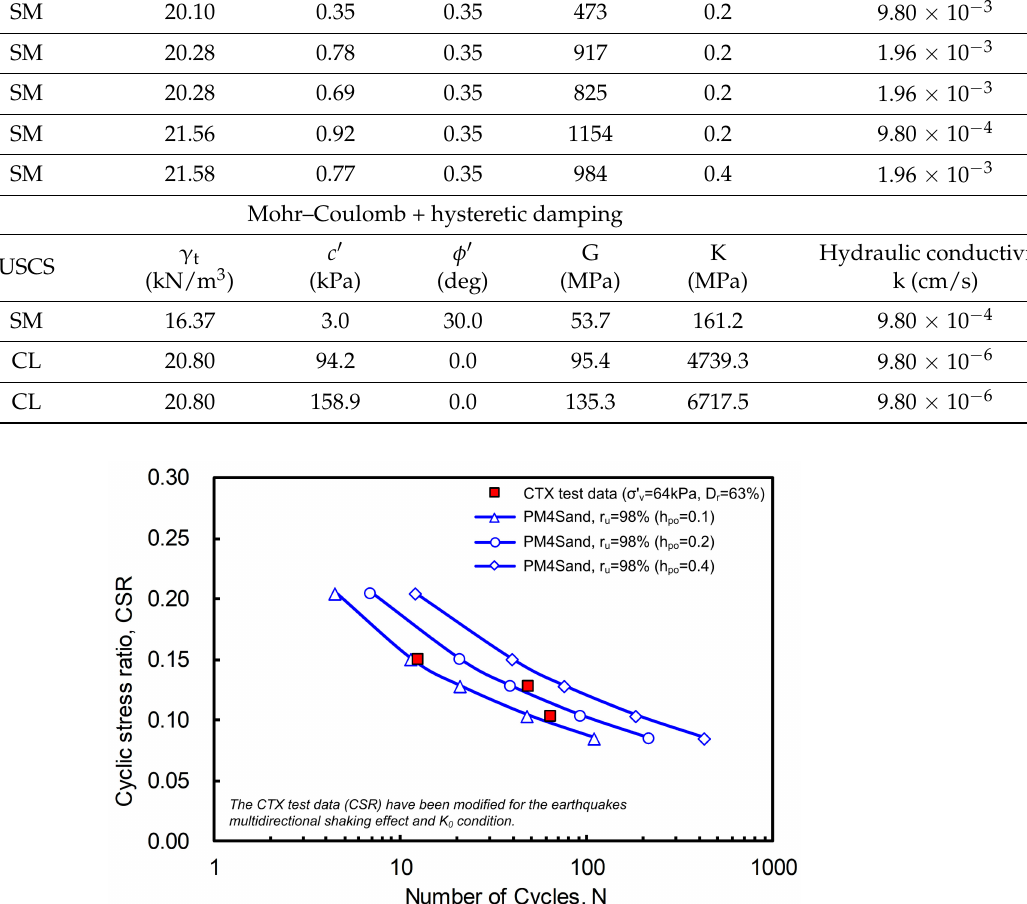
Figure 18. The calibration of h po based on the dynamic triaxial test results. Figure 19 shows the distribution of excess pore water pressure ratio (r u = ∆ u/ σ (cid:48) v0 ) at earthquake time of 10 s. In the figure, the sand layer (L4) has reached a liquefied state (r u ≈ 1.0). Figure 20 shows the excess pore water pressure ratio history of the central element of L4 layer during the earthquake. In the figure, the soil layer reached the initial liquefaction state when the earthquake time was at about 5.6 s, and the liquefaction state continued until the earthquake had lasted about 50 s. After 50 s, the excess pore water pressure gradually dissipated as the seismic wave acceleration amplitude decreased. From the change of the stress–strain curve and the stress path of the liquefied layer, it can be seen that with the liquefaction of the sand layer (L4) during the earthquake, the soil stiffness decreased and the slope of the stress–strain hysteresis circle became gentler, indicating that the soil began to soften as shown in Figure